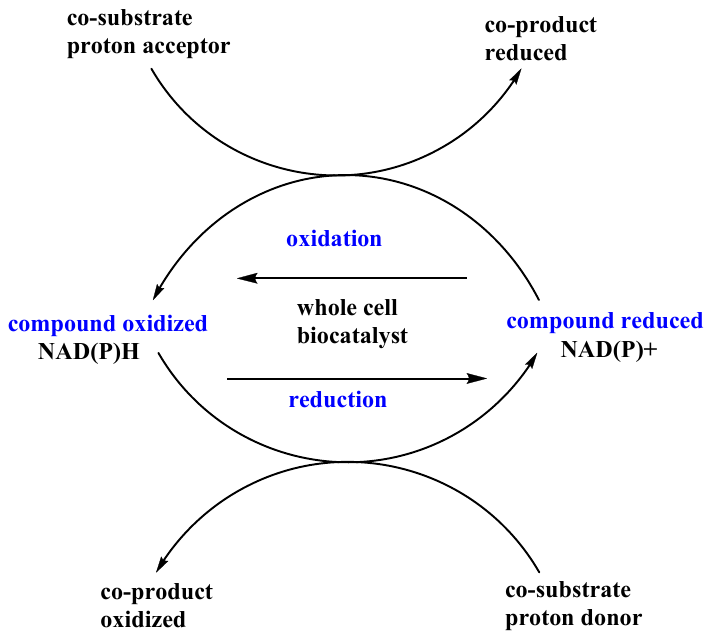
Figure 7. Co-substrates in oxidation and reduction